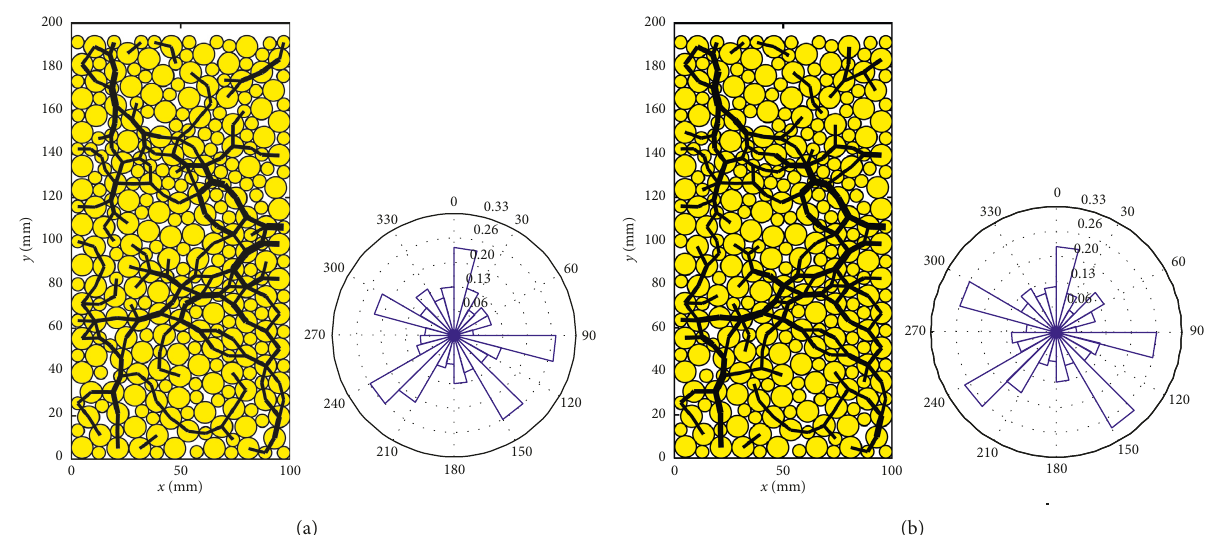
Figure 12: Distribution of force chain and force angle for unbonded particles in the DEM modelling, under the lever weights of (a) 0.5kg and (b)